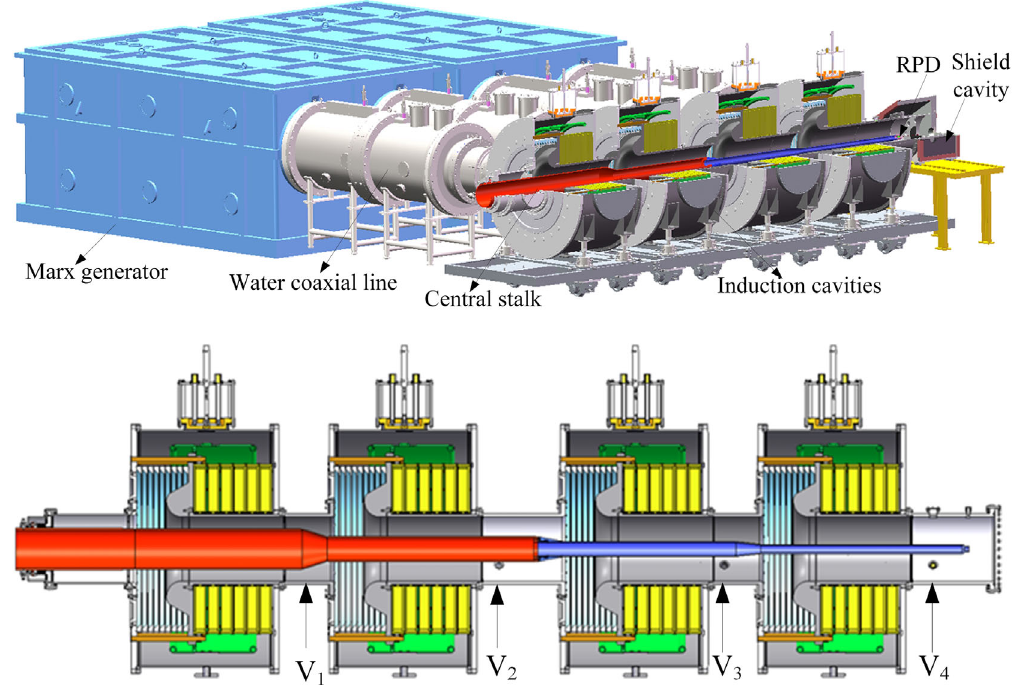
FIG. 1. (a) Overview of the 4 MV IVA-type flash x-ray radiographic machine named Jianguang-II and (b) the cross section to illustrate the four-stage induction cavities and the central stalk. Four capacitive voltage dividers were installed downstream of each cavity, which was labeled from V 1 to V 4 . This facility has a volume of 6 m × 9 m × 2 . 5